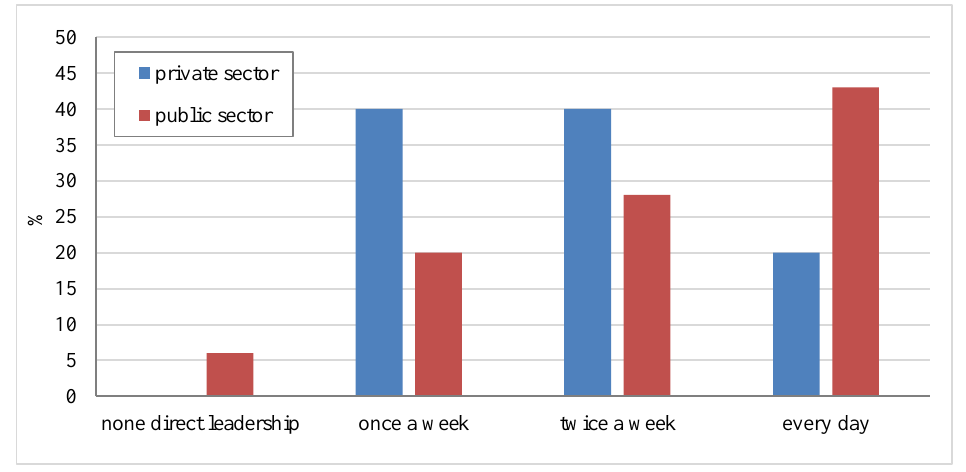
Figure 6. Frequency of direct